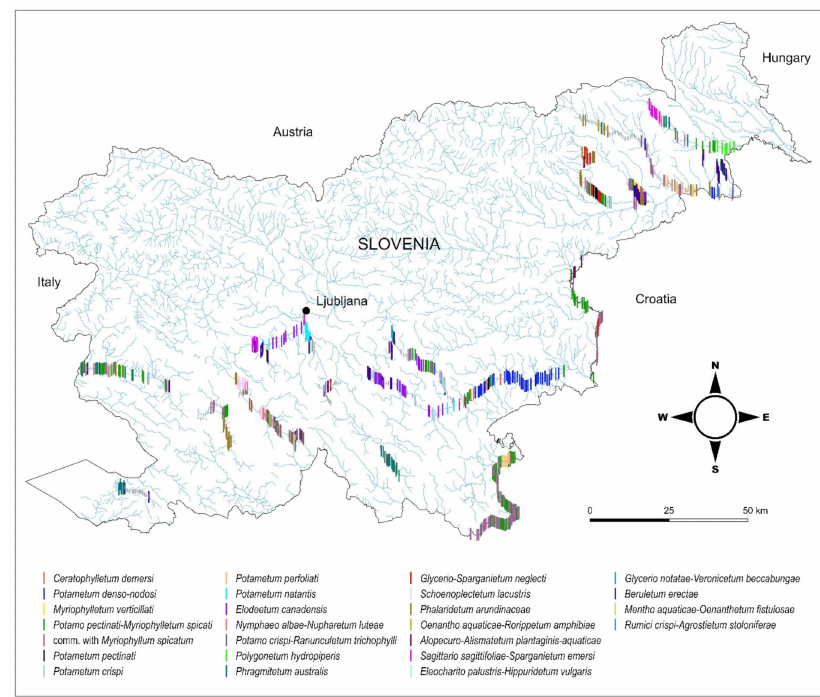
Figure 6. Plant communities in stretches of the surveyed